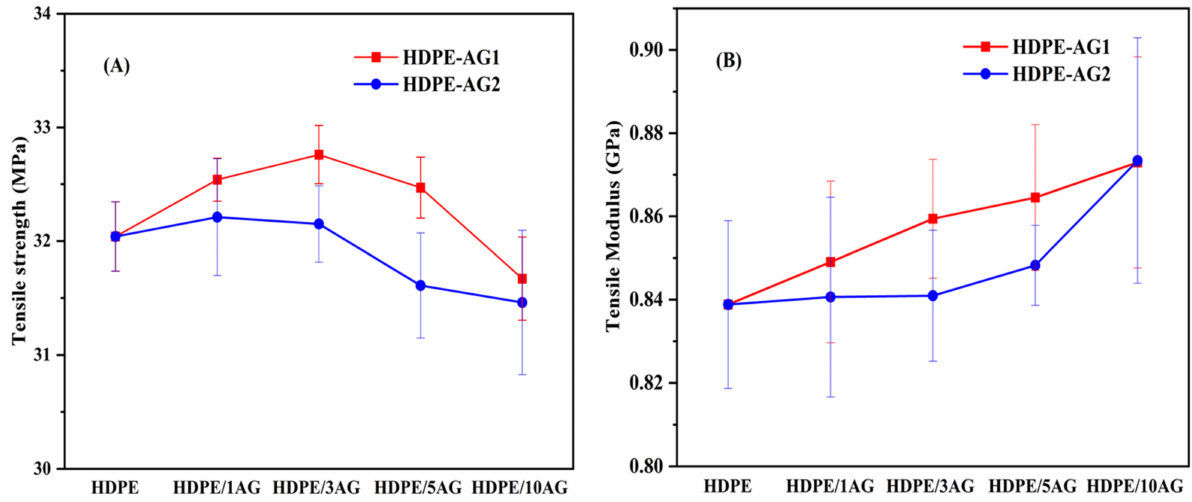
Figure 3. Tensile strength ( A ) and tensile modulus ( B ) in HDPE, HDPE/AG 1 , and HDPE/ AG 2